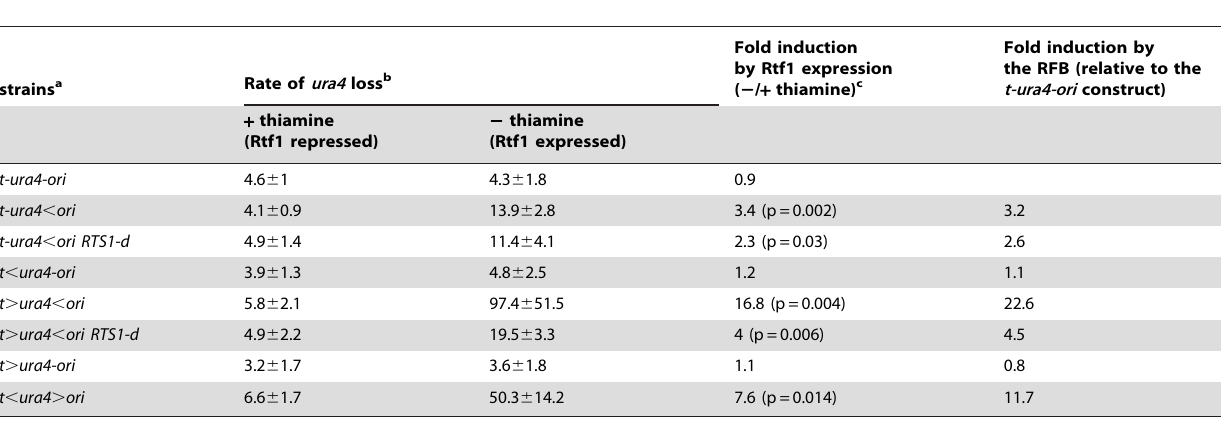
Table 1. Rates of ura4 loss (including genomic deletion, translocation, and mutation events), calculated using the method of the